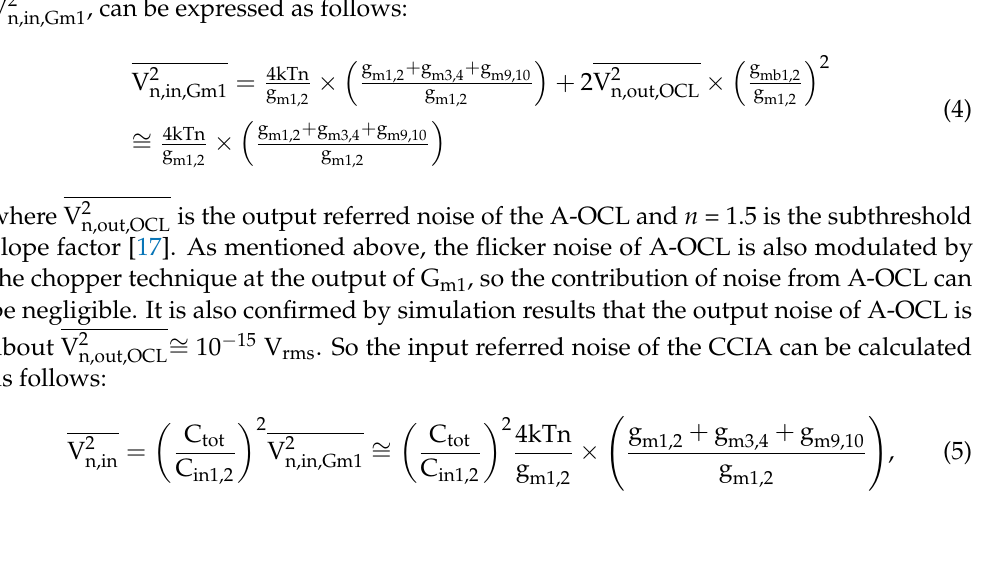
Figure 7. Schematic of the two-stage OTA G m3 in A-OCL.